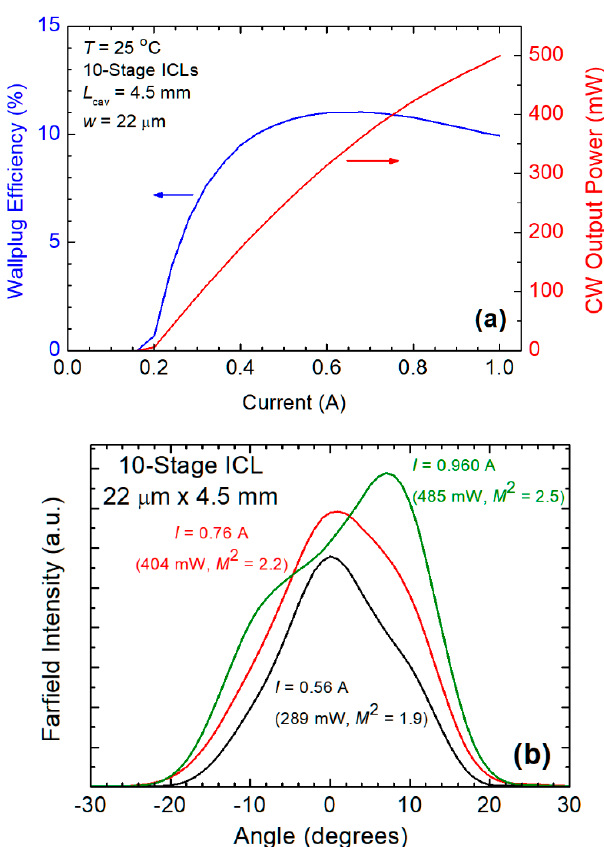
Figure 9. ( a ) L-I characteristics and wallplug efficiency in cw mode at T = 25 °C for a 10-stage ICL ridge with corrugated sidewalls. The ridge width is 22 μ m, the cavity length is 4.5 mm, and the facets are HR/AR coated. ( b ). Far-field emission profiles at several currents, along with extracted values of the beam quality factor [109].